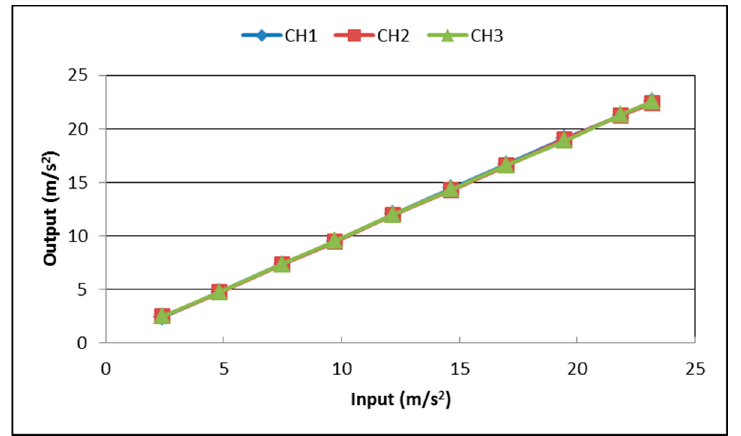
Figure 11. Input and output linear linearity for the data recorded on our instrument when placed on a jolt table.